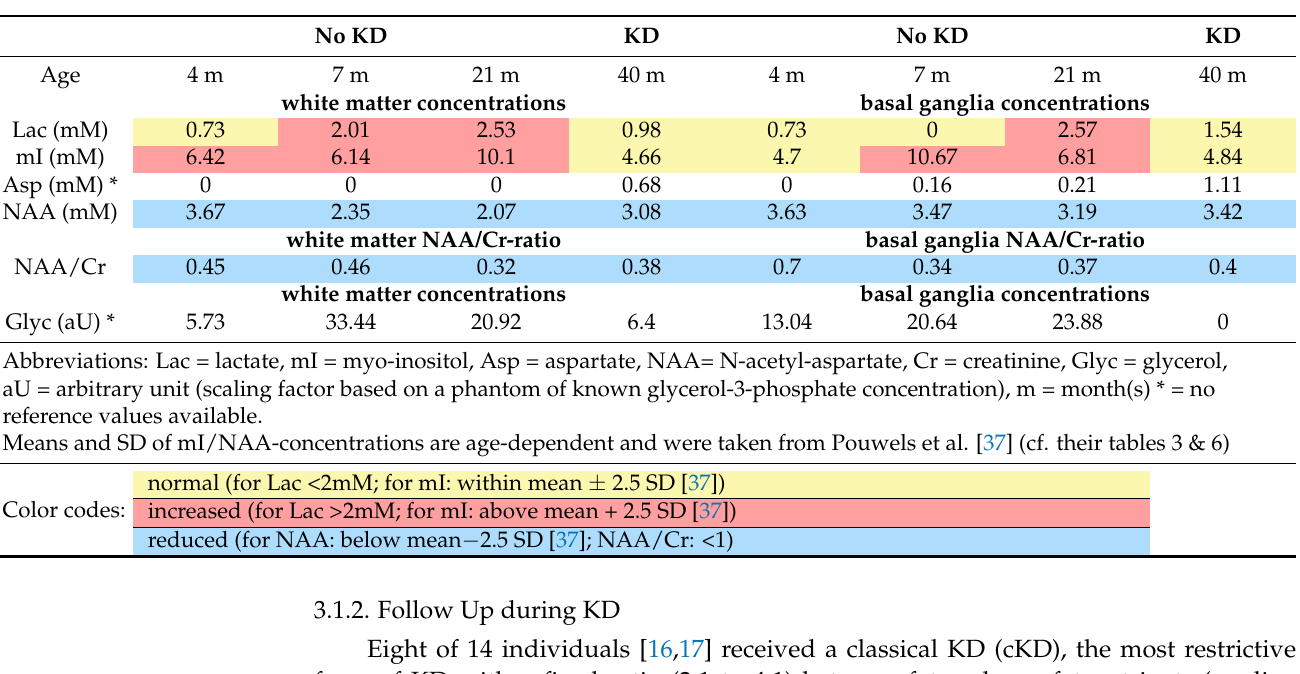
Table 5. MRS in AGC1-1 before and on ketogenic diet